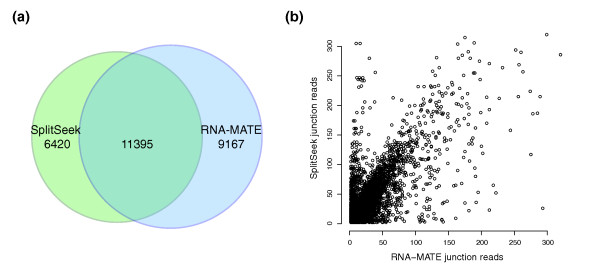
Comparison of predictions from RNA-MATE and SplitSeek. (a) Venn diagram showing the number of predicted junctions by the two methods. (b) Predicted number of junction reads for all for all 11,395 exon boundaries reported by both RNA-MATE (x-axis) and SplitSeek (y-axis).